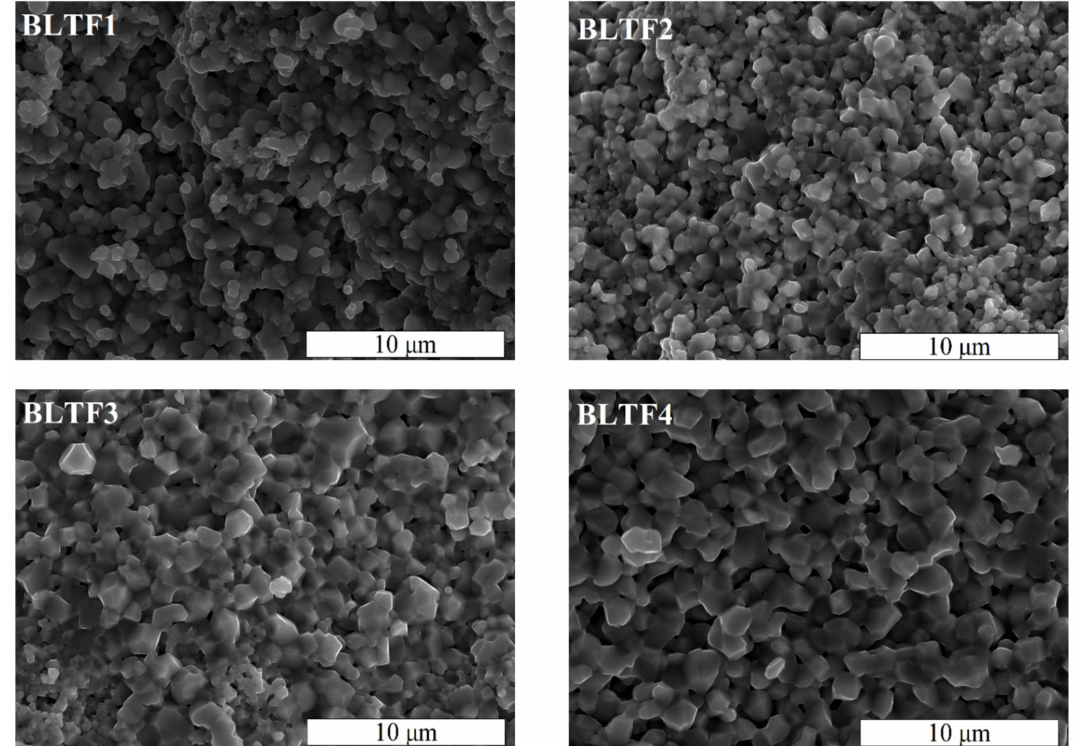
Figure 2. SEM images of BLTF1, BLTF2, BLTF3, and BLTF4 ceramics (5000 ×